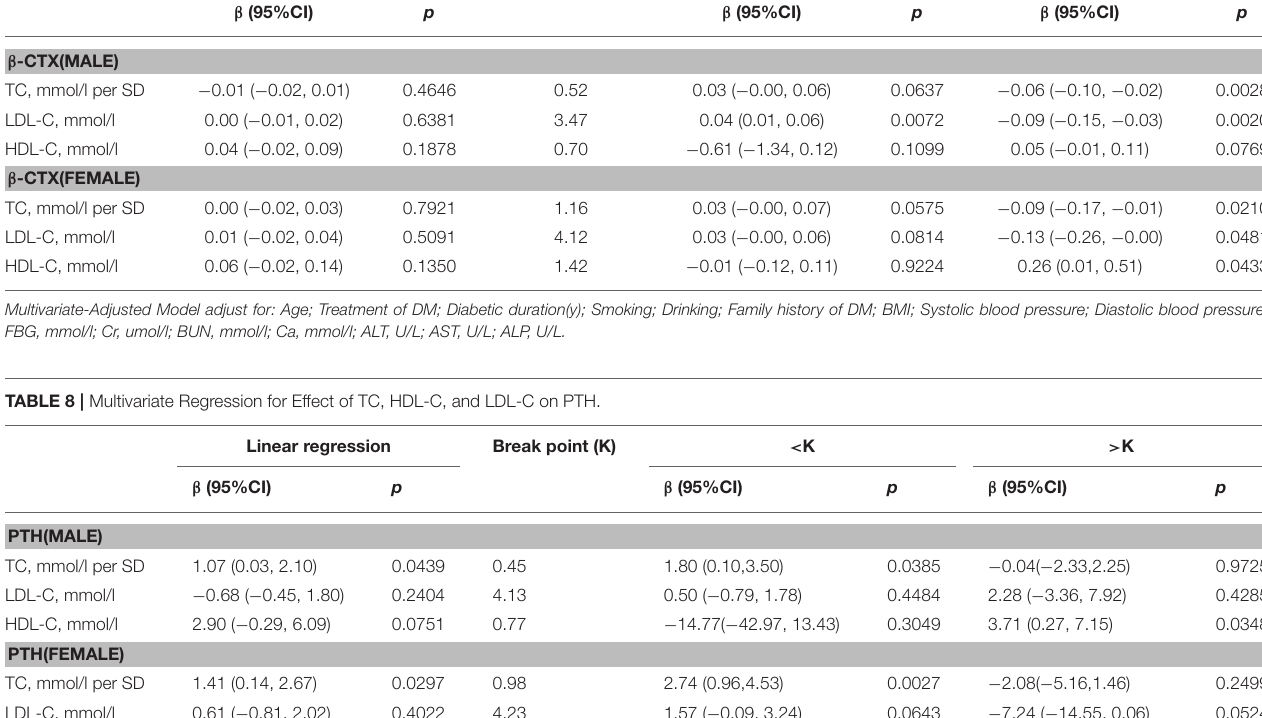
TABLE 7 | Multivariate Regression for Effect of TC, HDL-C, and LDL-C on β -CTX. Linear regression Break point (K) < K > K